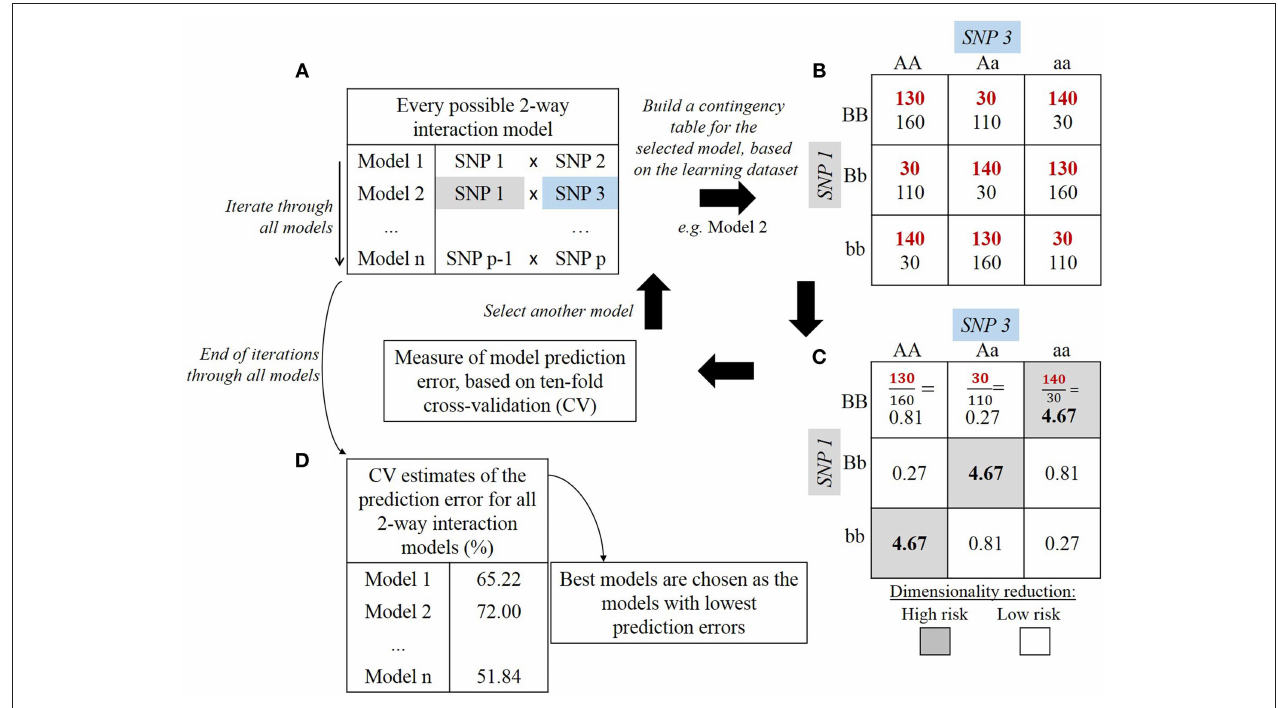
FIGURE 4 | Steps of multifactor dimensionality reduction (MDR) algorithm: example of 2-way interaction model. Description of one iteration of the cross-validation process. In (A) , a SNP combination is drawn among all potential SNP combinations. In (B) , numbers in red denote counts for cases whereas numbers in black denote counts for controls. In (C) , each cell displays the ratio of cases over controls. In (D) , the prediction error is estimated over the 10